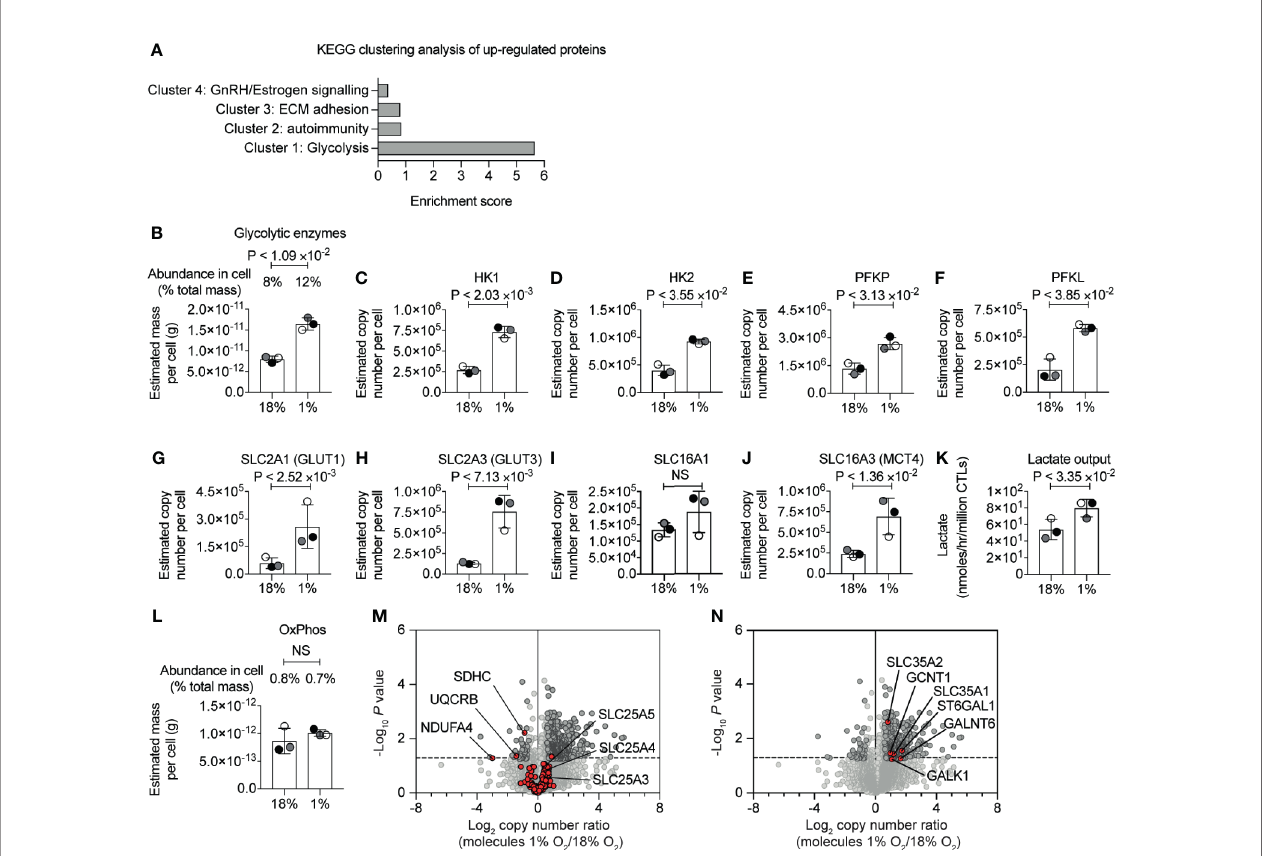
FIGURE 2 | Hypoxia-mediated changes to proteins involved in glucose metabolism. (A) Proteins increased in abundance in CTLs after 24 hours in hypoxia were evaluated for function using DAVID. The bar chart shows the enrichment scores for the clusters. (B) Graph showing the estimated mass of proteins in a cell, calculated using the proteomic ruler, annotated with the KEGG pathway term “ glycolysis ” . (C – J) Copy numbers estimated from the proteomic data for the indicated proteins. (K) Lactate output in normoxic and hypoxic CTLs. (L) Bar chart showing the estimated mass of proteins in a cell, calculated using the proteomic ruler, annotated with the KEGG pathway term “ Oxidative phosphorylation ” . (M, N) Volcano plots showing the protein copy number ratio in hypoxic vs normoxic CTLs. In (M) mitochondrial proteins involved in oxidative phosphorylation and metabolite transport are shown in red, with selected proteins annotated. In (N) proteins increased in abundance in hypoxic CTLs and involved in cellular glycosylation are highlighted in red and are annotated. Data in (A – N) show three biological replicates. In bar charts, data points from the individual biological replicates are shown and are colour matched, the bar shows the mean and the error bars show standard deviation. P values were calculated using a two-tailed paired t-test. Non-signi fi cant changes are marked